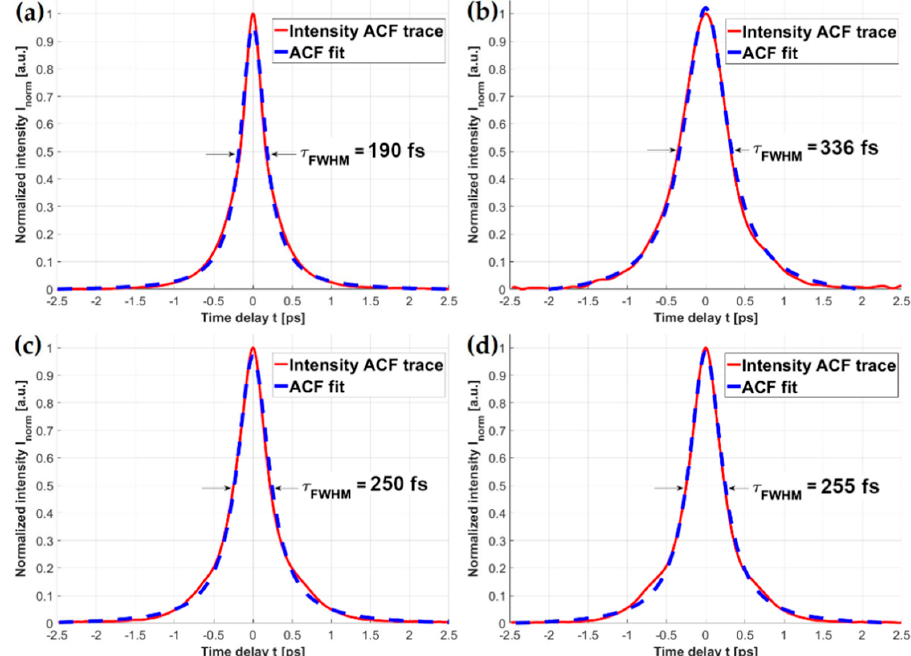
Figure 4. Autocorrelation function traces of femtosecond laser pulses transmitted through: ( a ) HCPBF; ( b ) MMF coupler; ( c ) HCPBF+MMF coupler, butt-coupled (prior to splicing); ( d ) HCPBF+MMF coupler, spliced. In 4b, c and d, the coupler output arm tip is microlensed. A noticeable reduction of the pulse width ( τ FWHM ) can be observed in the case of the combined HCPBF and MMF coupler, showing the feasibility of compensating dispersion effects, introduced by the solid-core fiber elements, with